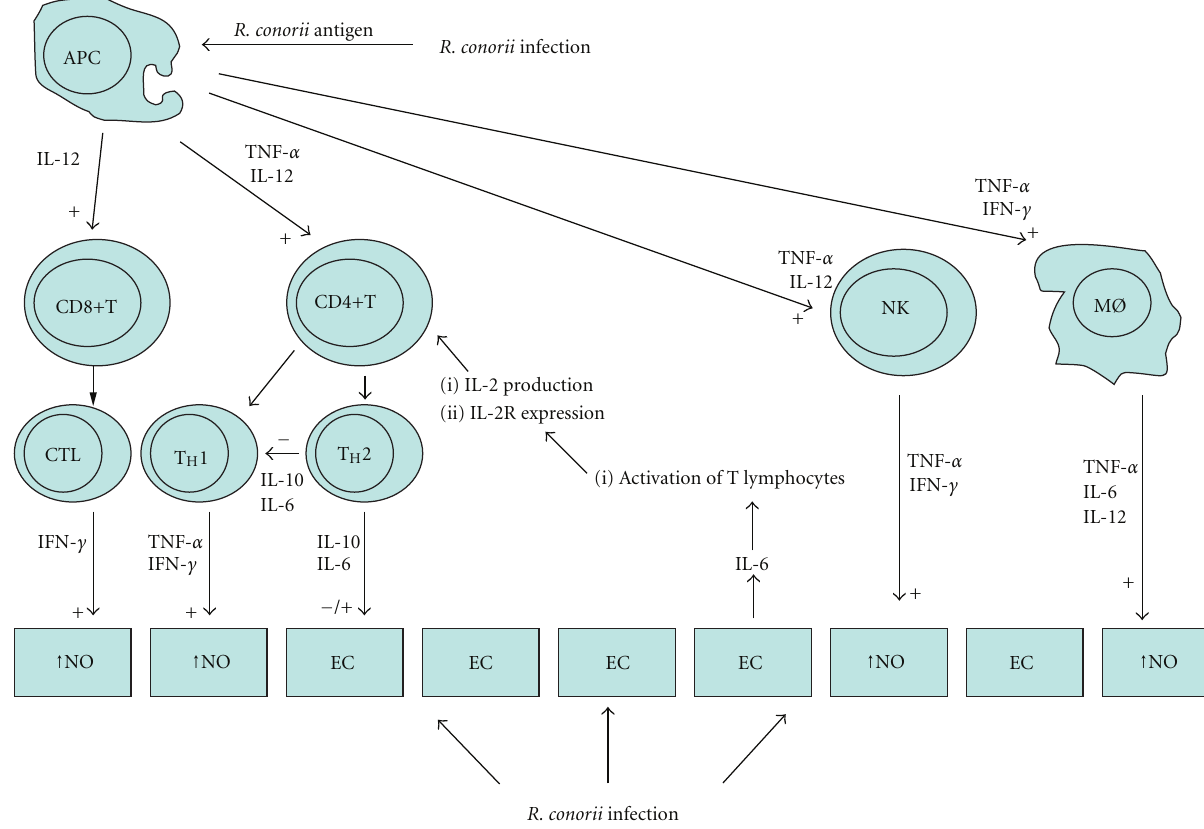
Figure 5: Immunologic alterations in rickettsial